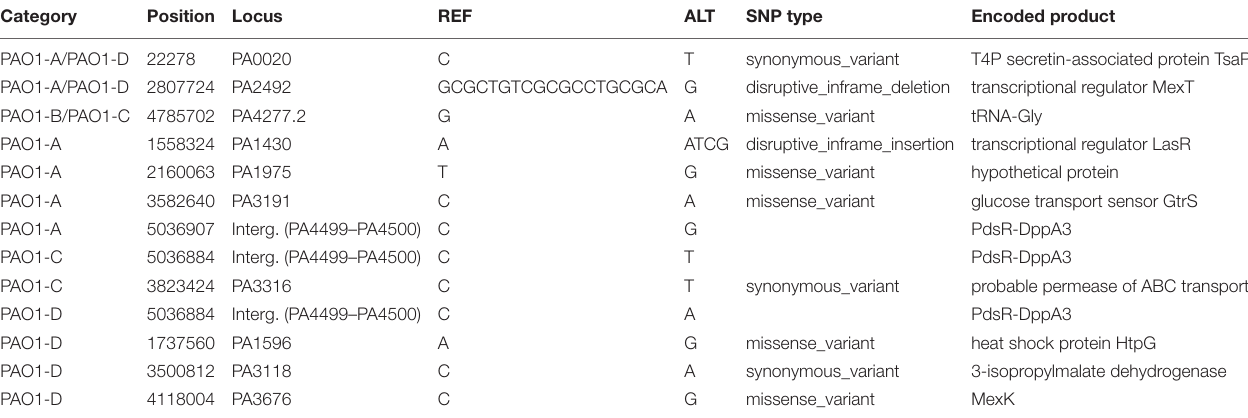
TABLE 2 | List of individual SNPs in each subline.